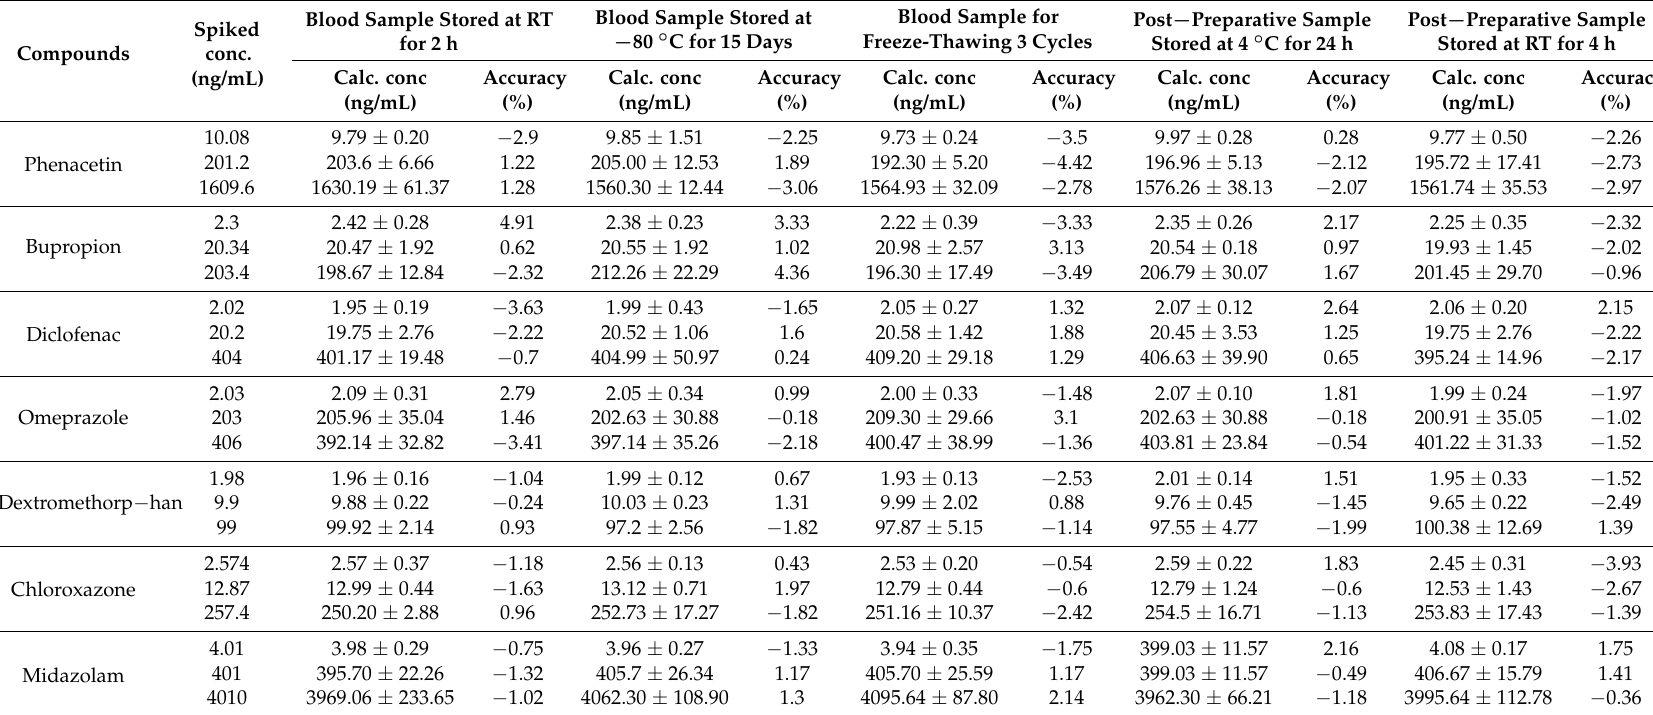
Table 4. Stability of seven probe drugs in rat plasma under various storage conditions ( n =